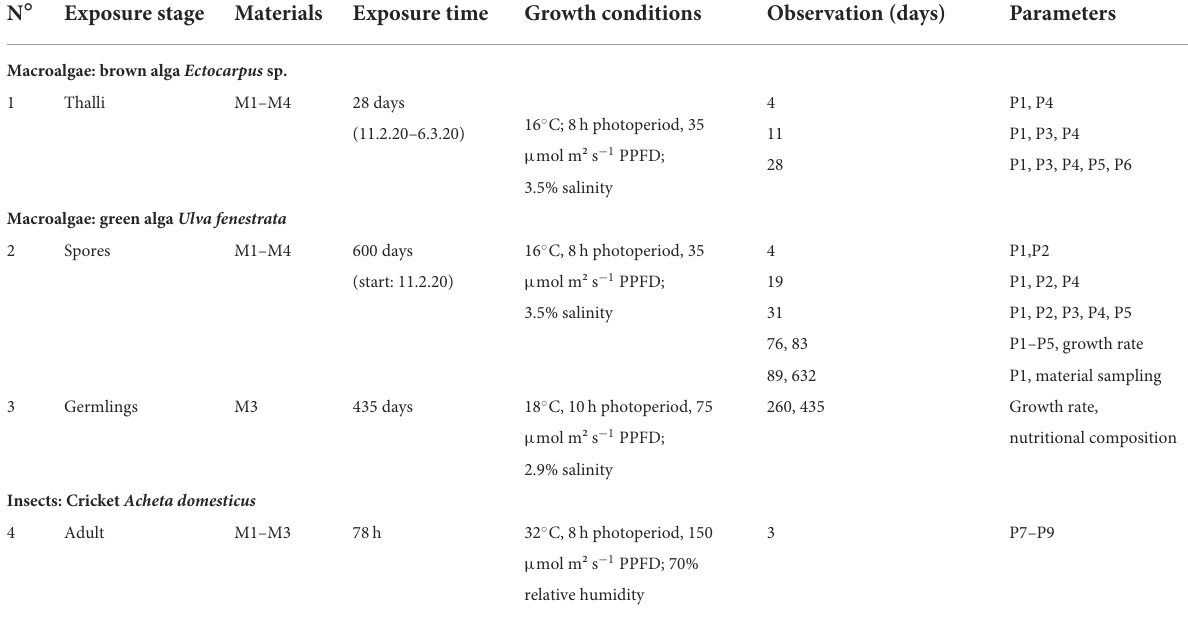
TABLE 2 Overview of four different organism-material exposure experiments. ◦ N Exposure stage Materials Exposure time Growth conditions Observation (days)